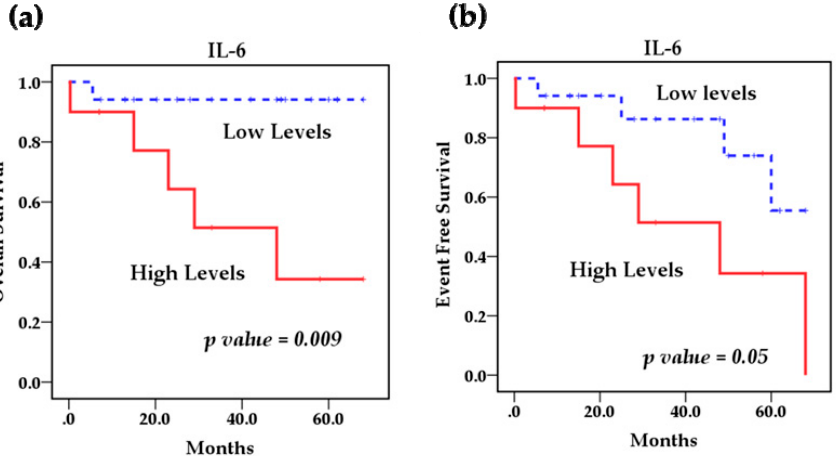
Cancers 2021 , 13 , x FOR PEER REVIEW 14 of 24 Figure 5. Kaplan–Meier curves comparing patients with high levels against those with low levels of IL-6: ( a ) Overall survival (OS) and ( b ) event-free survival (EFS).